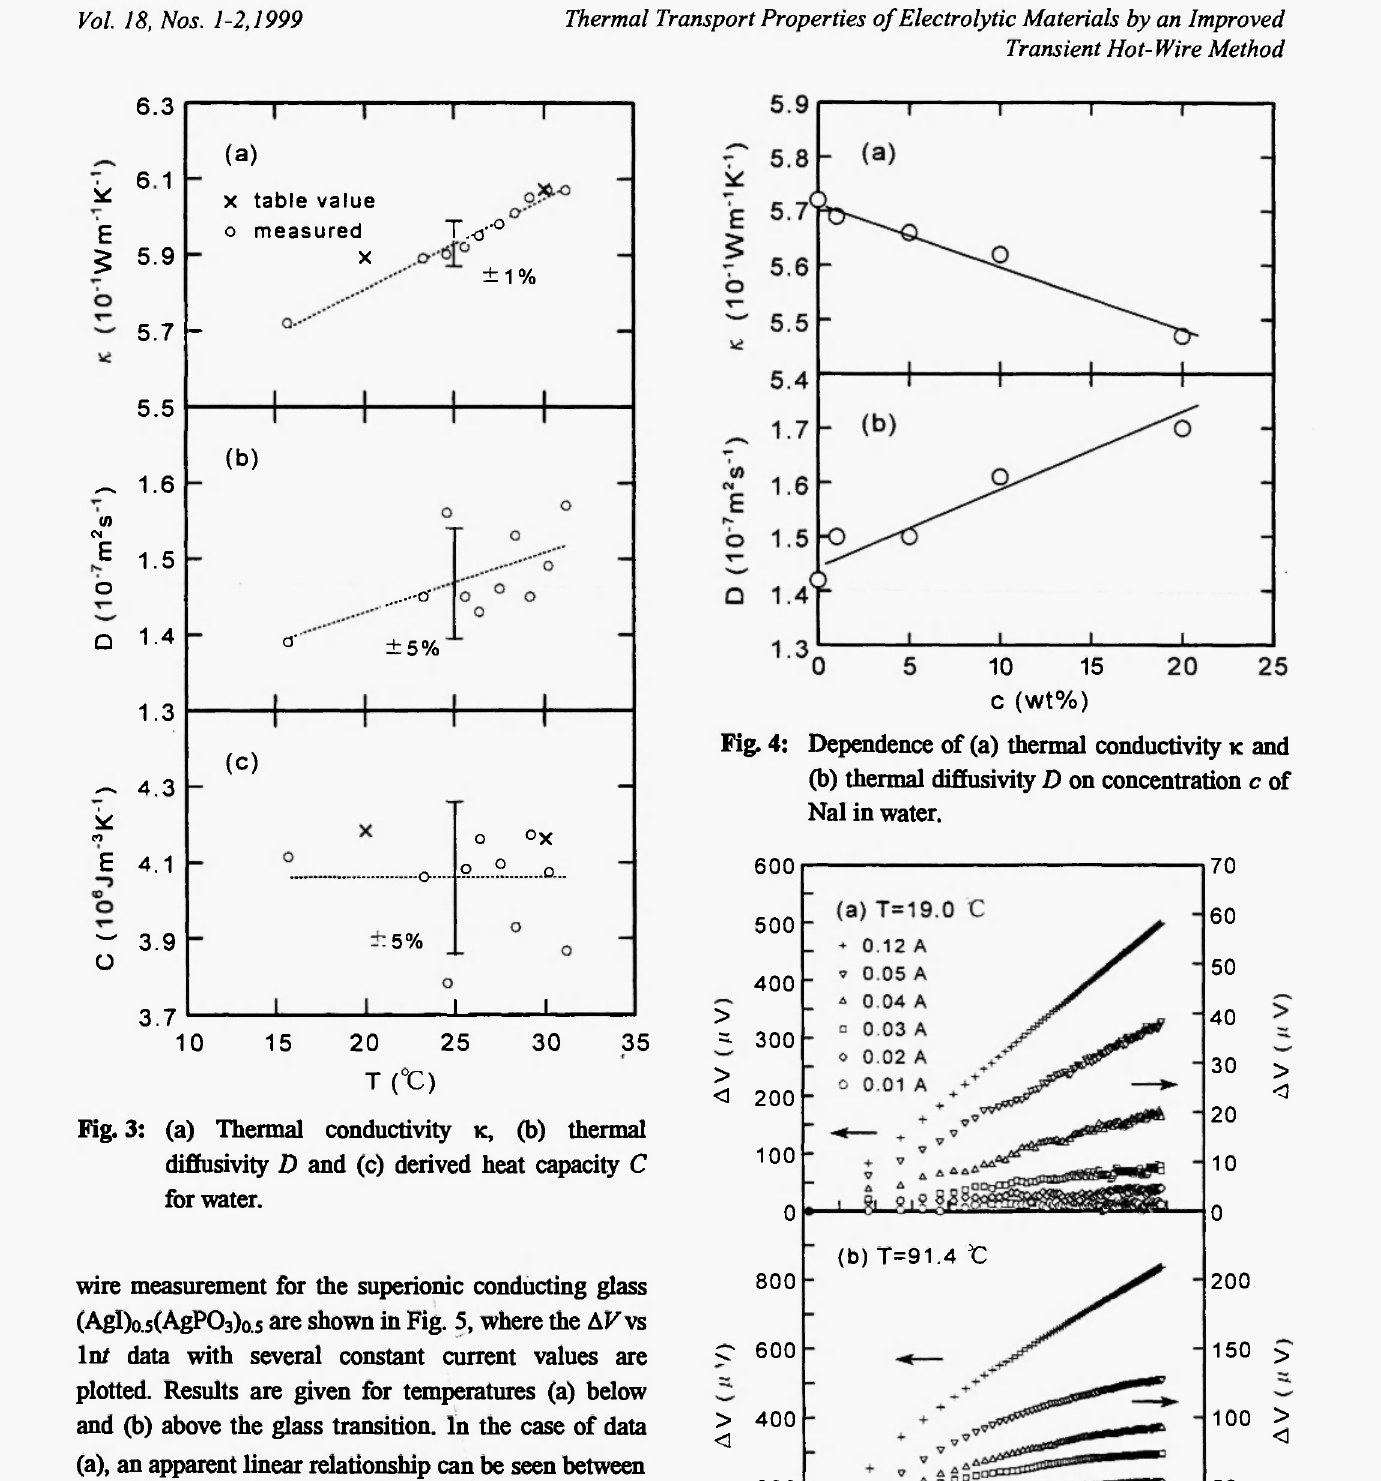
Fig. 3: (a) Thermal conductivity κ, (b) thermal diflusivity D and (c) derived heat capacity C for water.